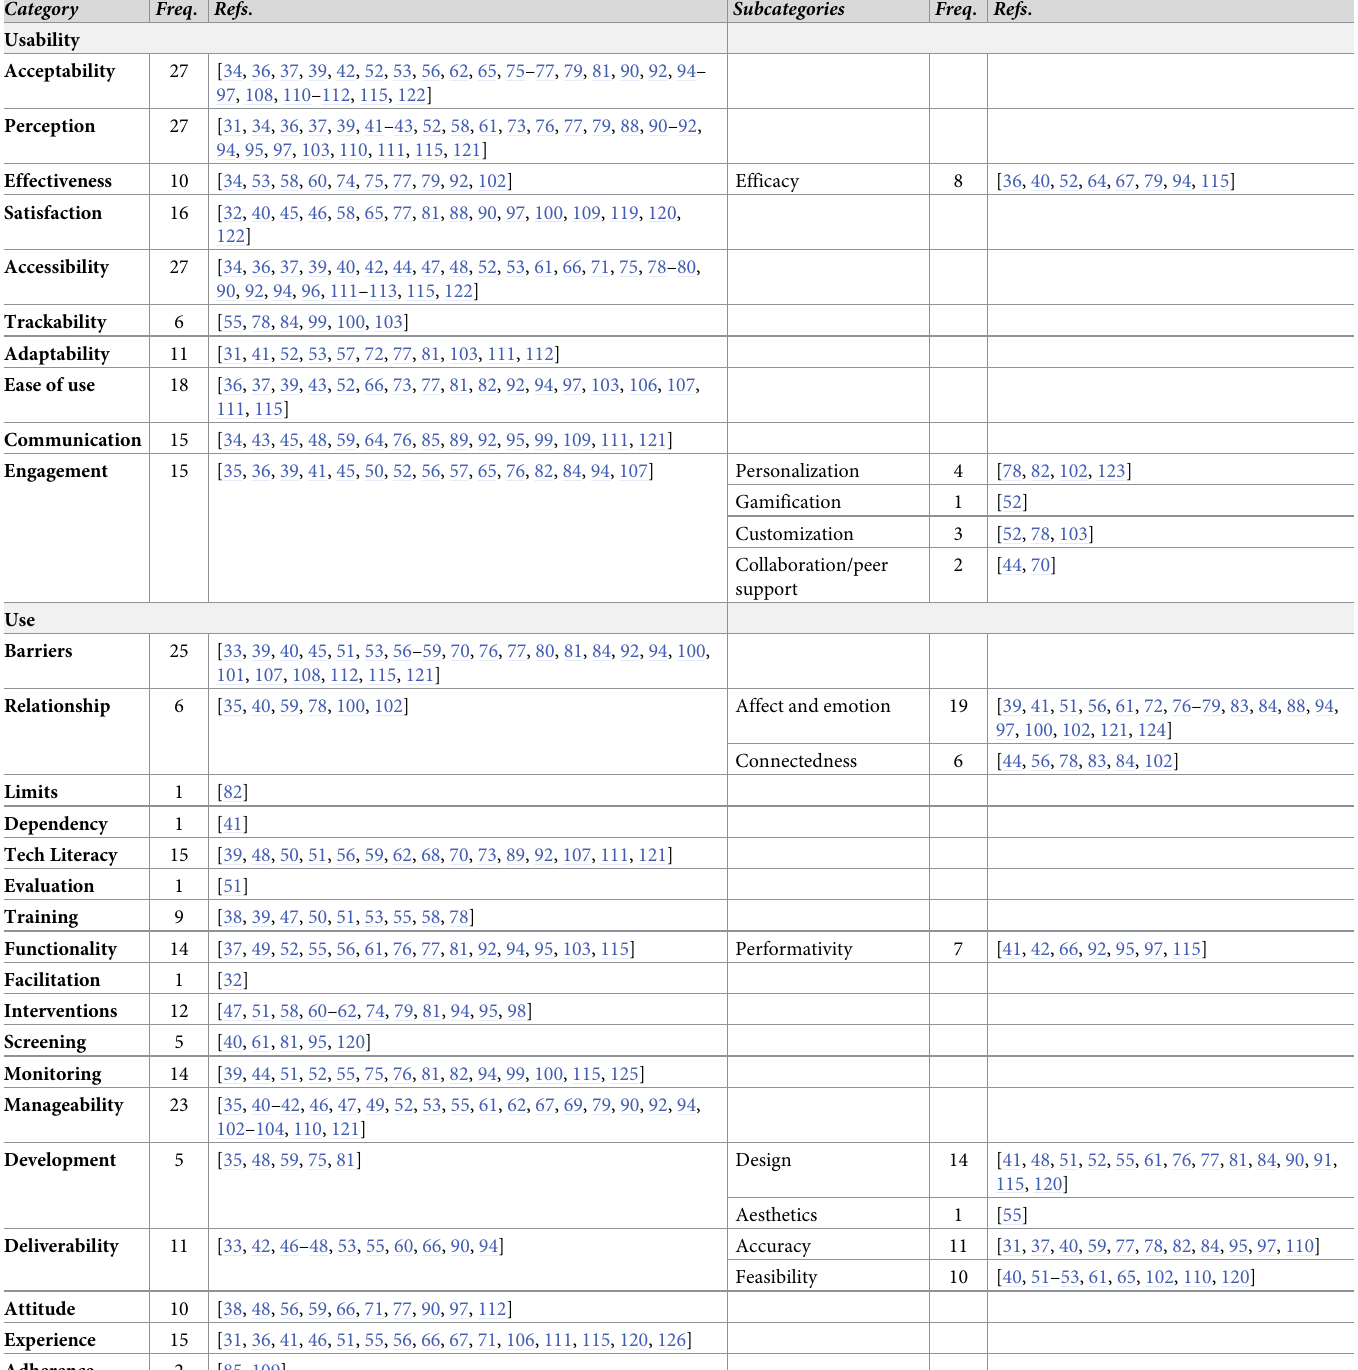
Table 7. Summary of findings in the reviewed literature: Use and usability. Category Freq . Refs . Subcategories Freq . Refs